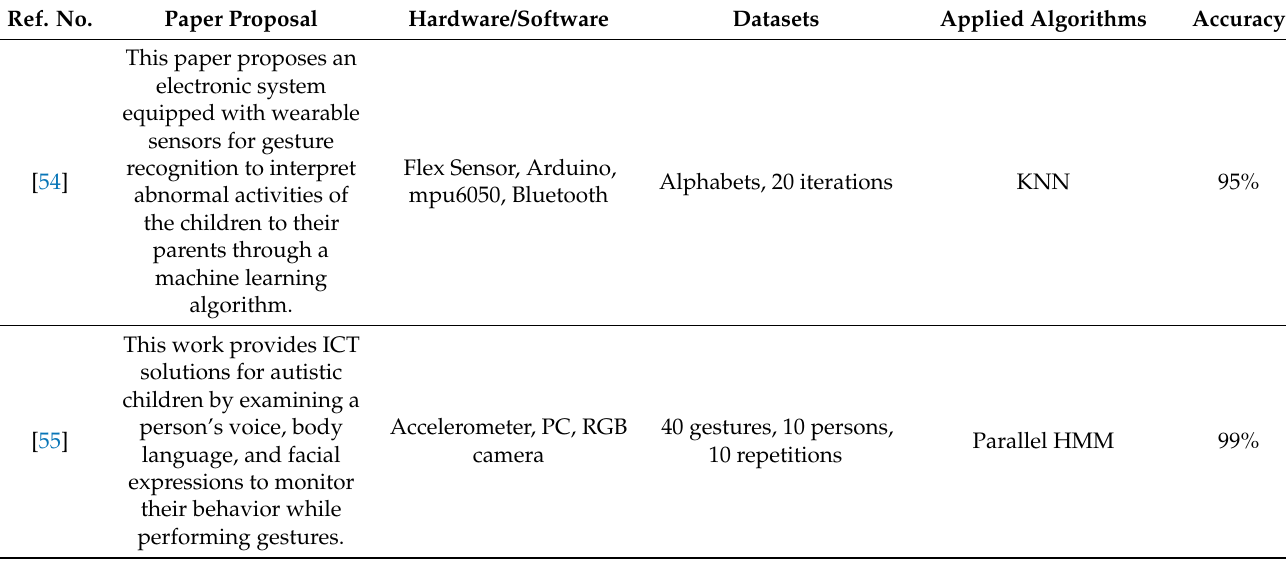
Table 2. Literature review related to